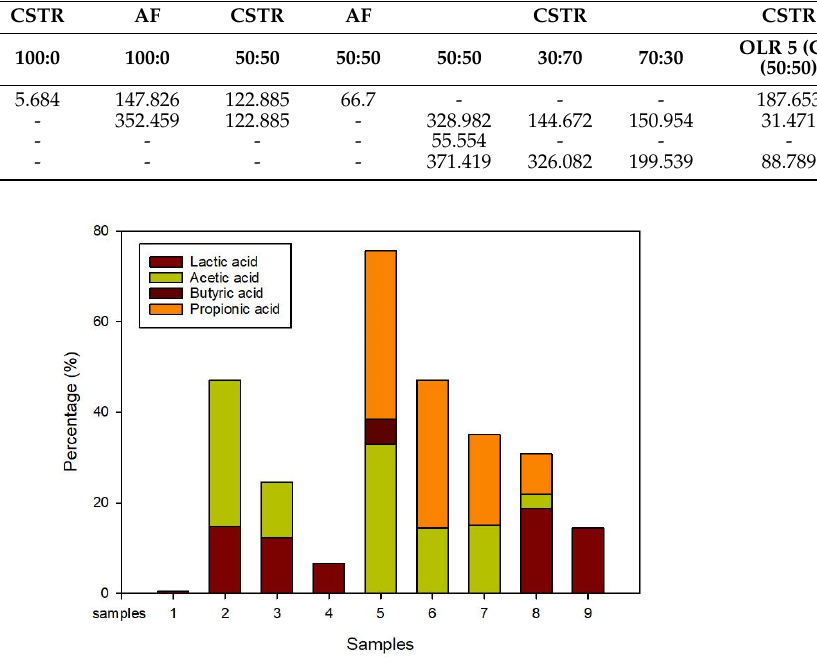
Figure 6. The proportion of 4 volatile fatty acids (VFAs) during different organic loading rates (OLRs).